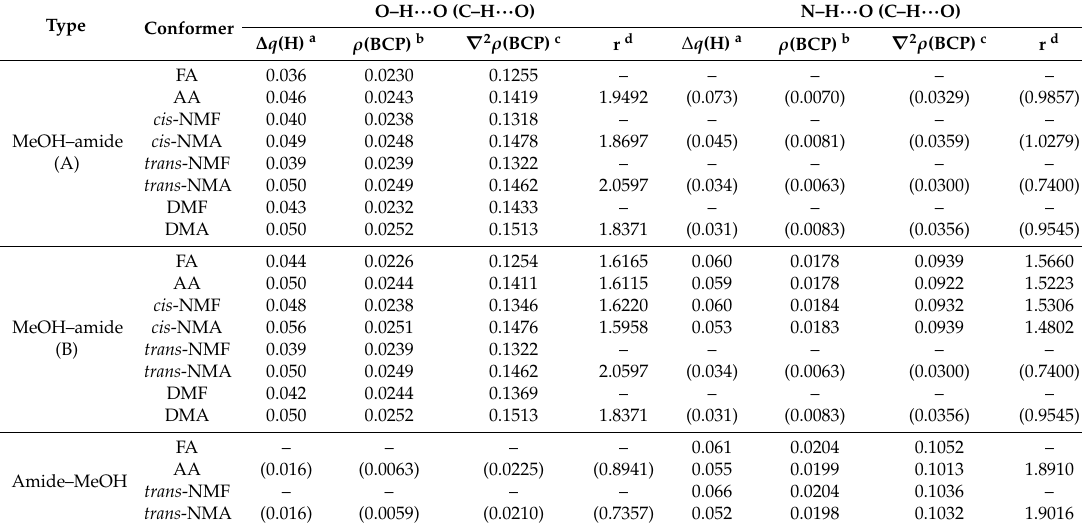
Table 4. Atoms in Molecules (AIM) parameters for the MeOH–amide and amide–MeOH complexes obtained at the B3LYP-D3/aug-cc-pVTZ level (distances in Å; all other values in